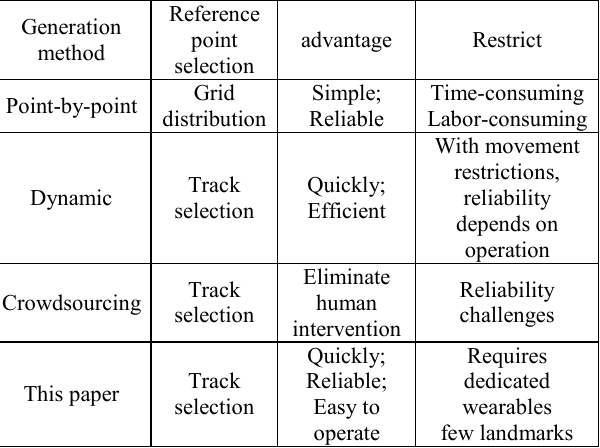
Table 1. Wireless Positioning Database Generation Method